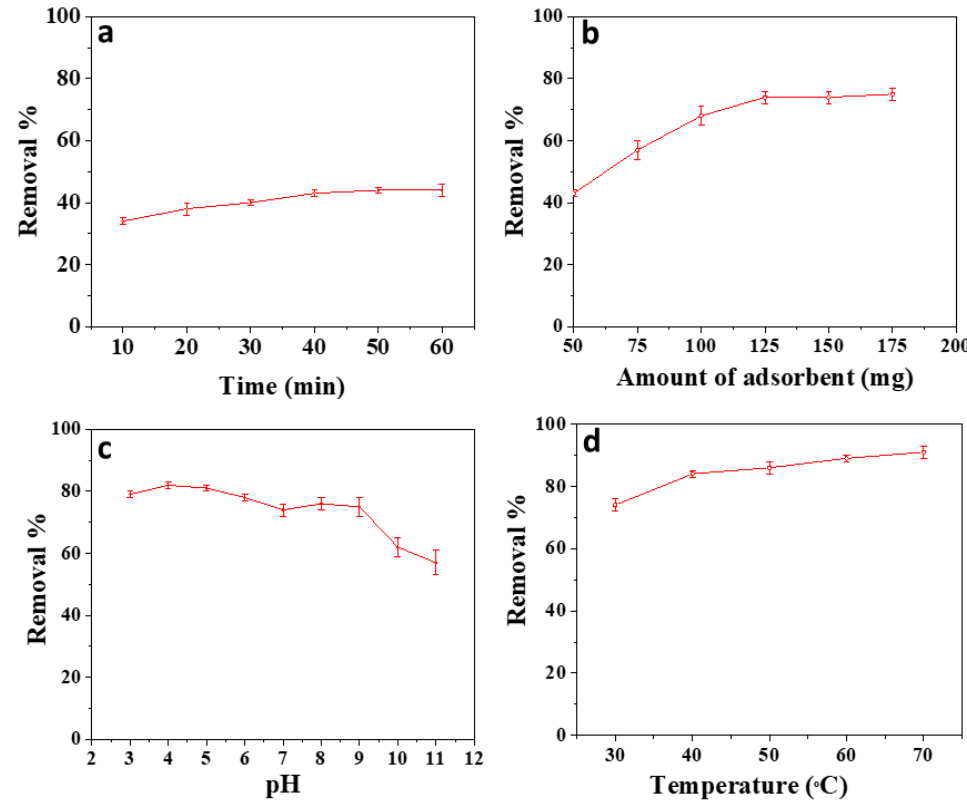
Figure 6. ( a ) Effect of contact time on adsorbent (GO–cellulose composite) of phenol= 30 mg L −1 ; pH 7; adsorbent = 50 mg; and temperature = 30 ± 2 °C. ( b ) Effect of adsorbent dose on adsorption of pH 7; adsorbent = 50 mg; and temperature = 30 ± 2 ◦ C. ( b ) Effect of adsorbent dose on adsorption of phenol = 30 mg L −1 ; pH 7; shaking time = 40 min; and temperature = 30 ± 2 °C. ( c ) Effect of pH on the phenol = 30 mg L − 1 ; pH 7; shaking time = 40 min; and temperature = 30 ± 2 ◦ C. ( c ) Effect of pH on adsorption of phenol onto GO–cellulose composite = 30 mg L −1 ; adsorbent = 125 mg; shaking time = the adsorption of phenol onto GO–cellulose composite = 30 mg L − 1 ; adsorbent = 125 mg; shaking 40 min; and temperature = 30 ± 2 °C. ( d ) Effect of temperature on the adsorption of phenol onto GO– time = 40 min; and temperature = 30 ± 2 ◦ C. ( d ) Effect of temperature on the adsorption of phenol cellulose composite = 30 mg L −1 ; adsorbent = 125 mg; shaking time = 40 min; and pH 7. onto GO–cellulose composite = 30 mg L − 1 ; adsorbent = 125 mg; shaking time = 40 min; and pH